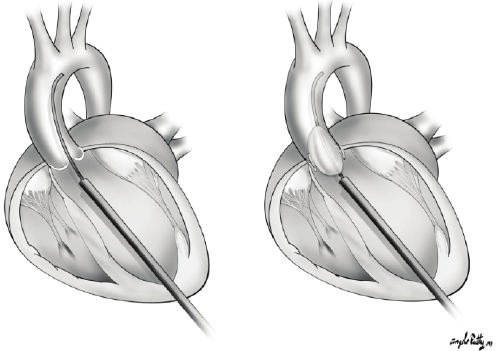
Figure 3: Illustration of the correct needle placement to allow for wire passage and balloon inflation across the aortic valve.